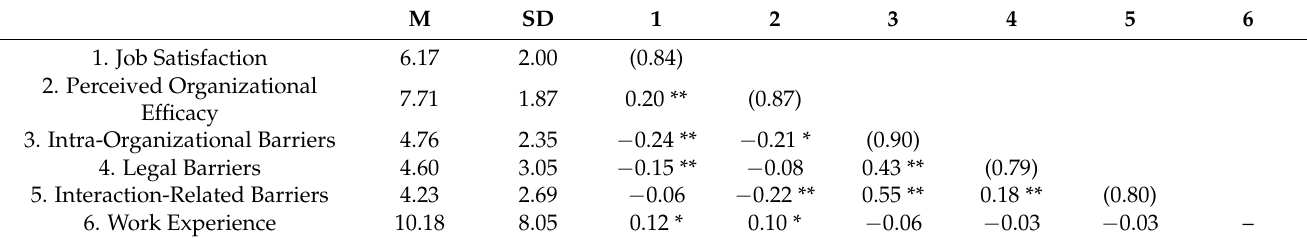
Table 1. Descriptive Statistics and Correlations for Key Study